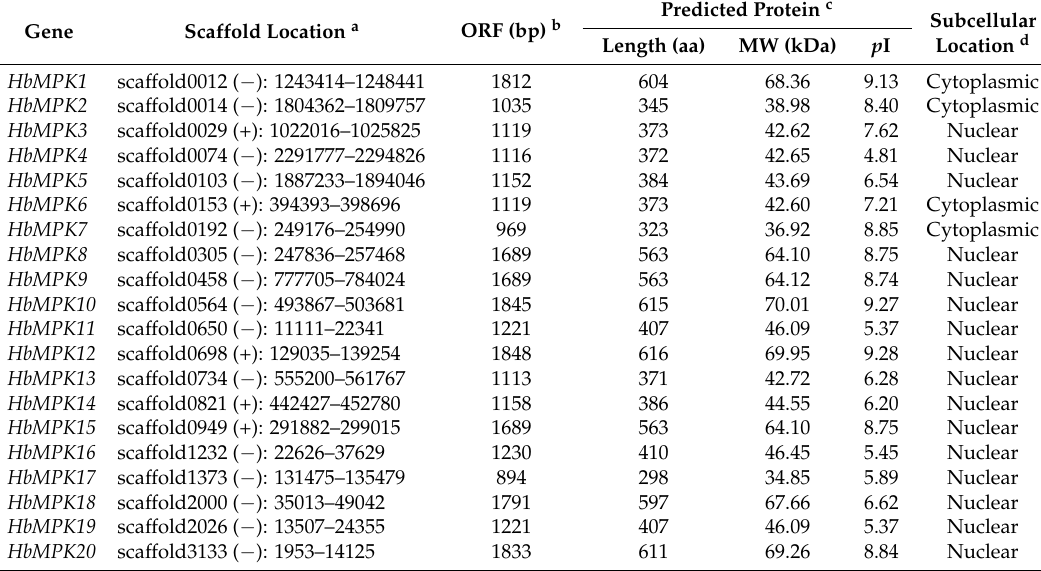
Table 1. Detailed information on putative HbMPK genes.